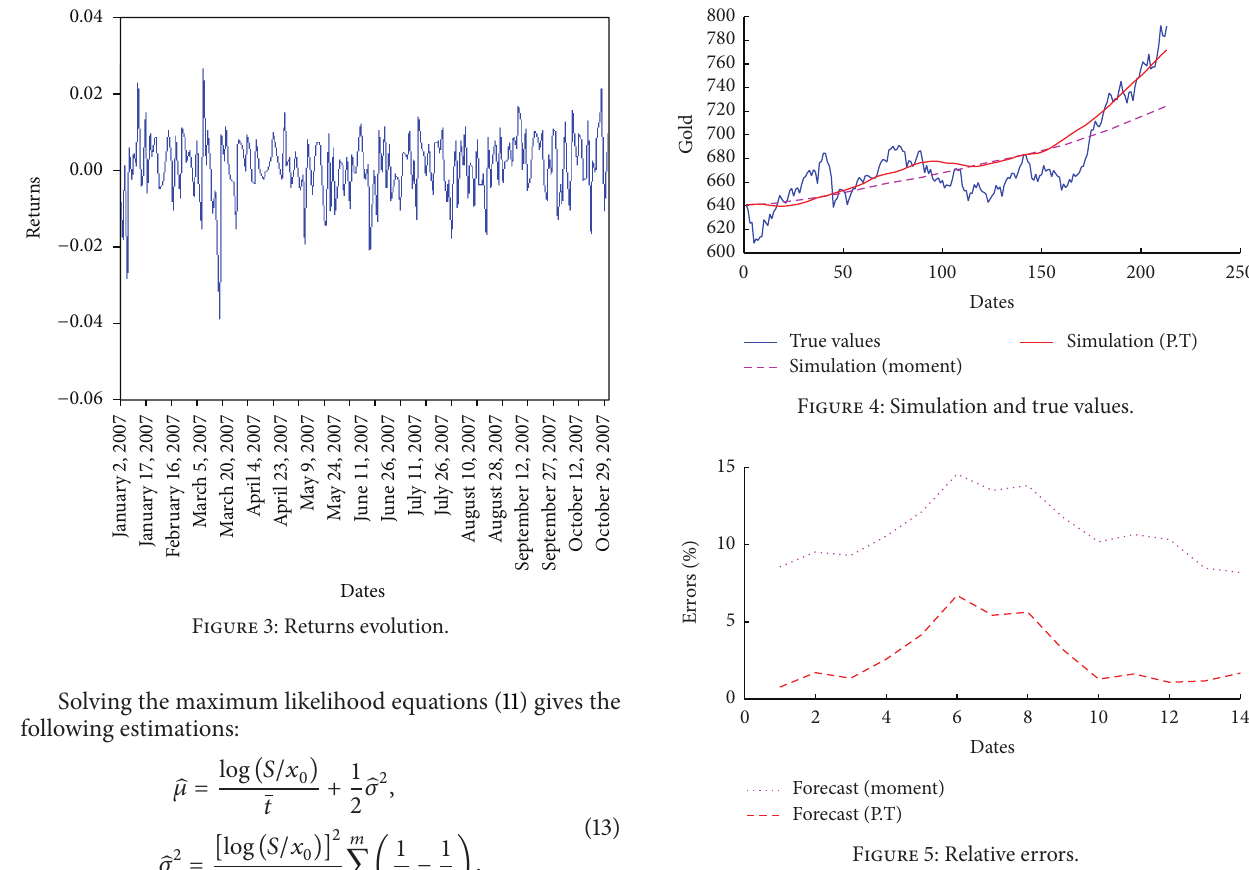
Figure 5: Relative